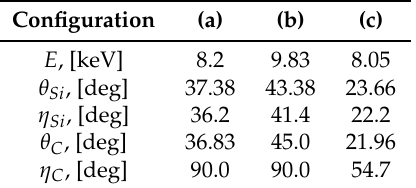
Table 1. Parameters of the experimental configurations shown in Figure 1.